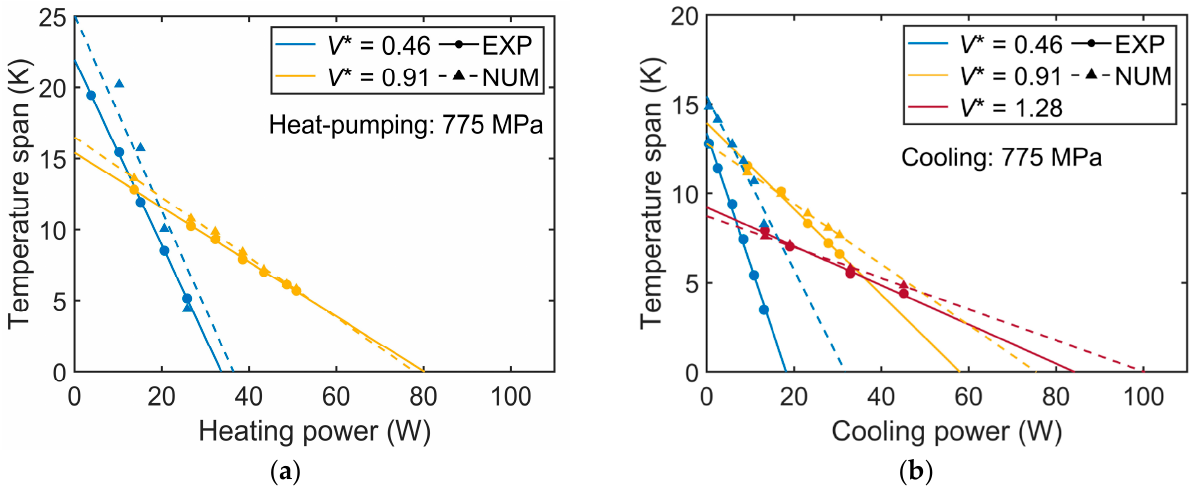
Figure 8. Comparison between experimentally determined and numerically calculated temperature span—cooling/heating power characteristics for heat-pumping ( a ) and cooling ( b ) at a stress level of 775 MPa.